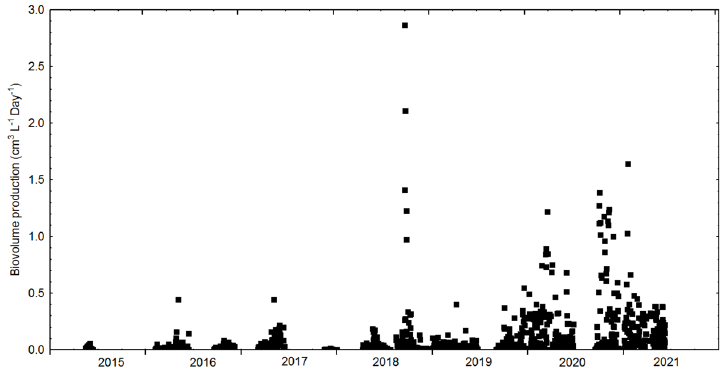
Figure 11. Production measured as biovolume pooled from all reactors.